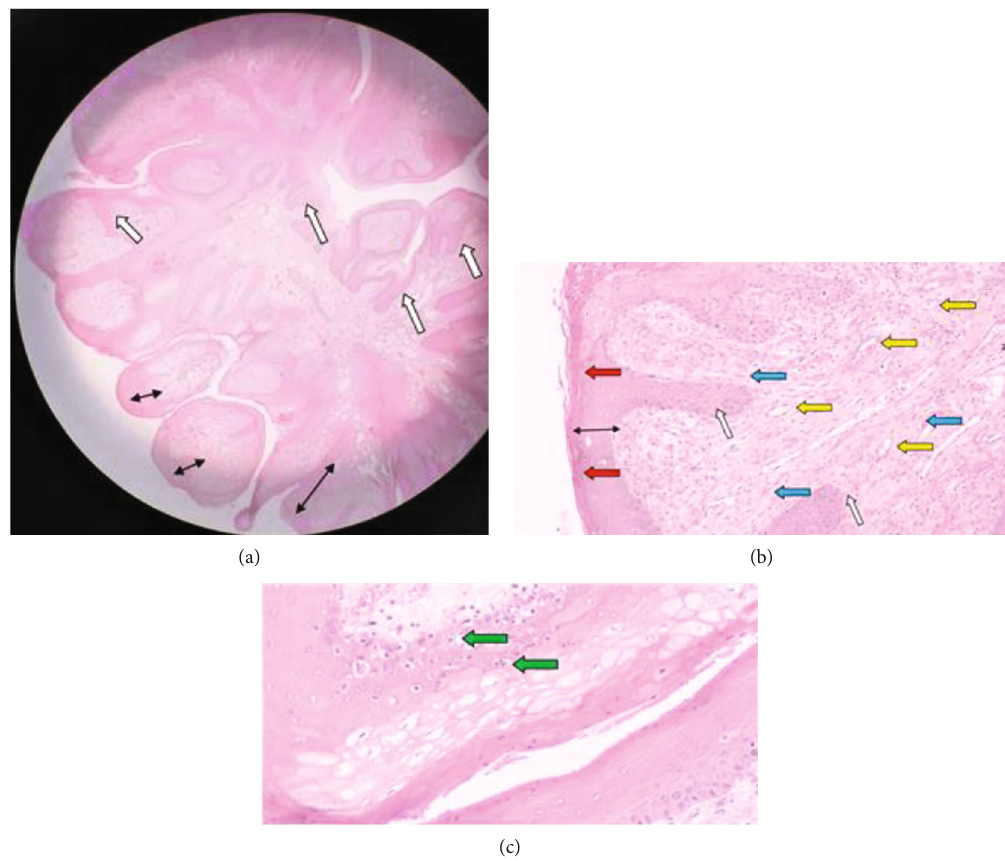
Figure 2: The histopathology result in this case of caprine papilloma tissues. (a) Overall hyperproliferation on the epidermis layer, characterized by thickening of the epidermal layer (black, double head arrow) and formation of rete peg which from epidermis layer extended to dermis layer (white arrow), indicating acanthosis. (b) Presence of nucleated cells within the stratum corneum (red arrow), indicating parakeratotic hyperkeratosis. Evidence of angiogenesis with the presence of the luminal structure surrounded by the endothelial cell (yellow arrow) and fi lled with some red blood cells. Hypercellularity of the dermis layer, fi lled with spindle-shaped fi broblast (blue arrow). (c) Presence of ballooning cell indicating koilocytosis (green arrow). H&E staining and magni fi cation (a) 4x, (b) 10x, and (c)